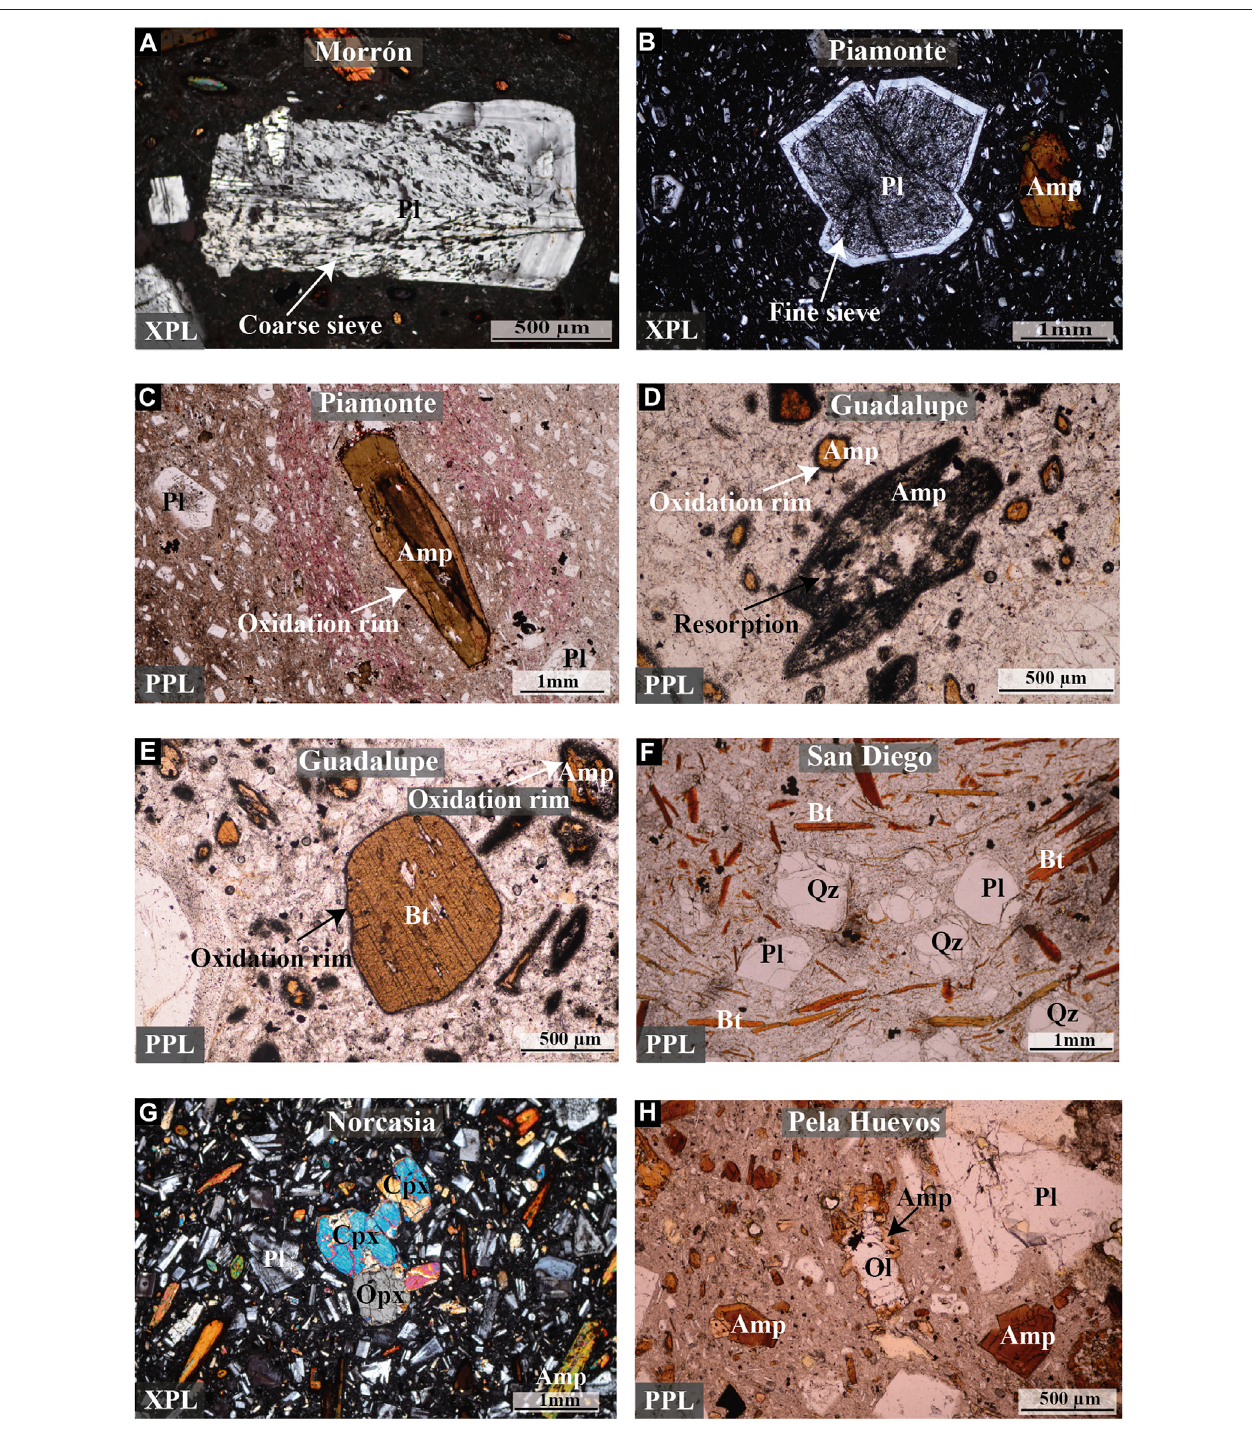
FIGURE 3 | Photomicrographs of petrographic characteristics. (A) Coarse sieve texture in plagioclase. (B) Fine sieve texture in plagioclase surrounded by a clean rim. (C) Greenamphibolewithanoxidationrim. (D) Brownamphibolecrystalswithoxidationrimsandresorptiontexture. (E) Biotiteandamphibolecrystalswithoxidation rims. (F) Quartz crystals and biotite with oxidation rims. (G) Clinopyroxene and orthopyroxene glomerocryst. (H) Olivine surrounded by brown type amphibole. respect to SiO 2 can be recognized and a positive correlation Norcasia volcanoes ( Figure 7 ). A negative correlation with K 2 O ( Figure 7 ). Whole-rock chemistry data from all samples are reported in Table 3 . between TiO 2 , Al 2 O 3 , MgO, CaO, Sr, V, and Sc with